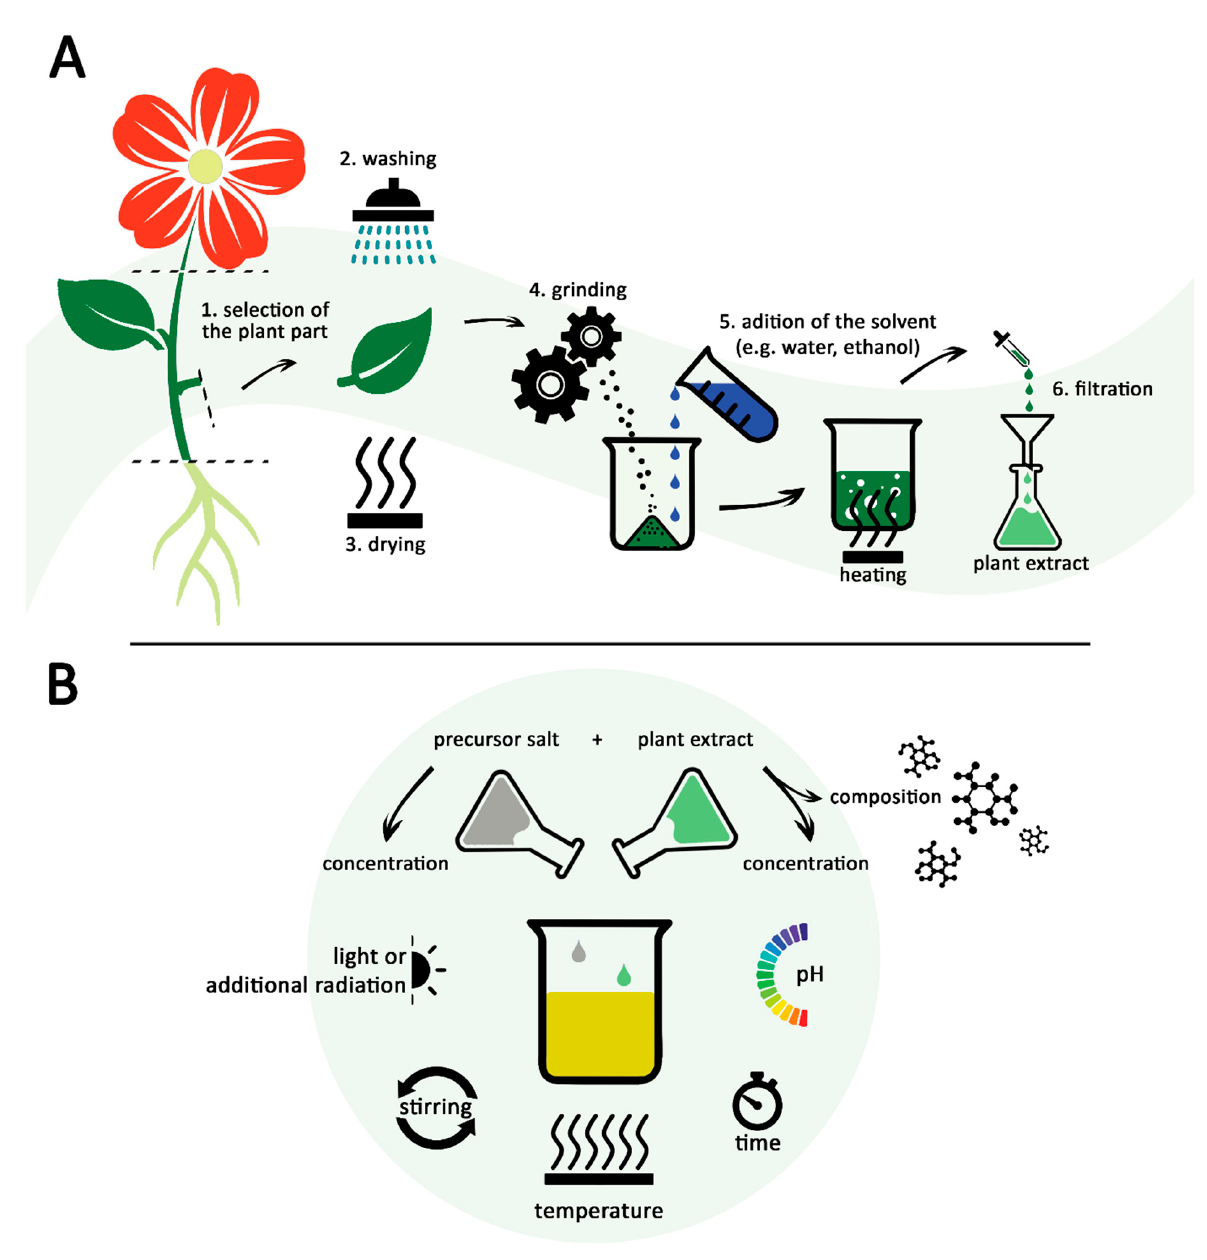
Figure 1. The typical approach of green synthesis of NPs: ( A ) Preparation of the plant extract; ( B ) factors affecting the reaction of green synthesis and the characteristics of the resulted NPs.